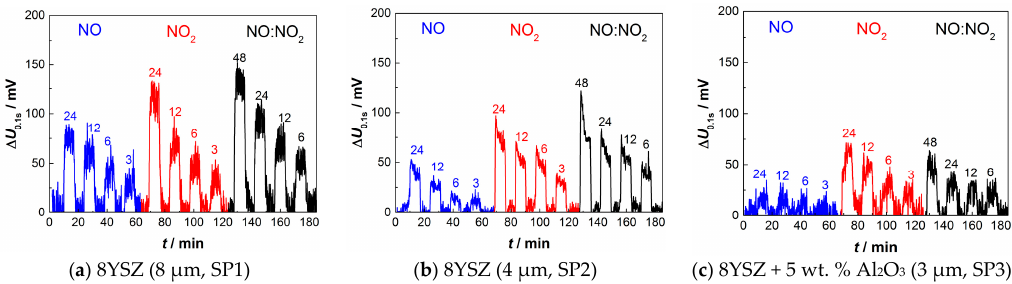
Figure 10. Sensor output voltage Δ U 0.1s of three different sensors at NO and NO 2 concentrations between 24 ppm and 3 ppm, and NO:NO 2 (1:1) mixtures between 48 ppm and 6 ppm, after alternating pulses. All sensors consist of a screen-printed 8YSZ solid electrolyte and an overlying platinum electrode also produced by screen-printing and sintering: ( a ) doubly screen-printed 8YSZ with 8–9 µm thickness; ( b ) single screen-printed 8YSZ with 4 µm thickness; and ( c ) single screen-printed mixture of 8YSZ and 5 weight % Al 2 O 3 with 3 µm thickness